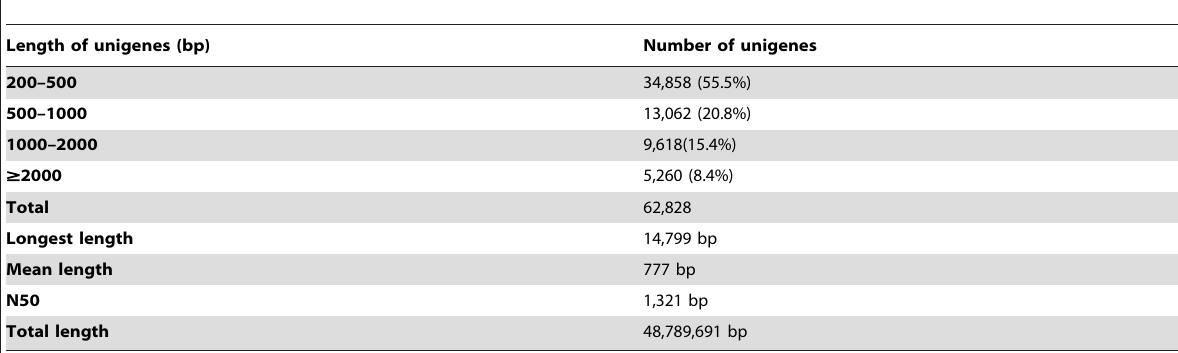
Table 1. Statistics for the unigenes of the common